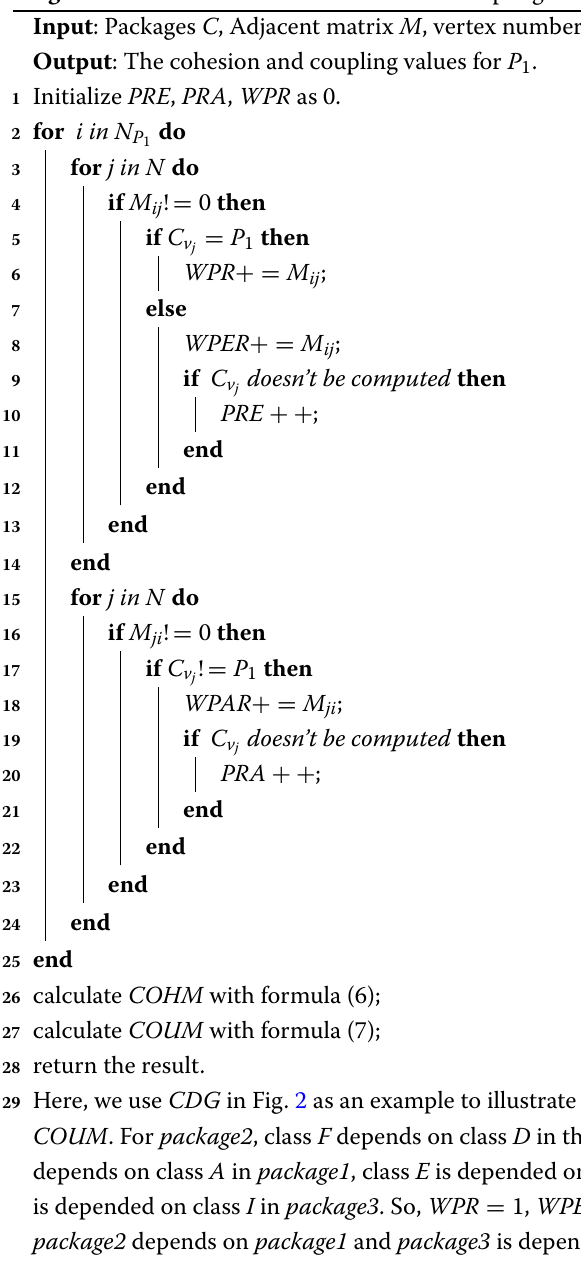
Algorithm 1: Calculation of cohesion and coupling for a